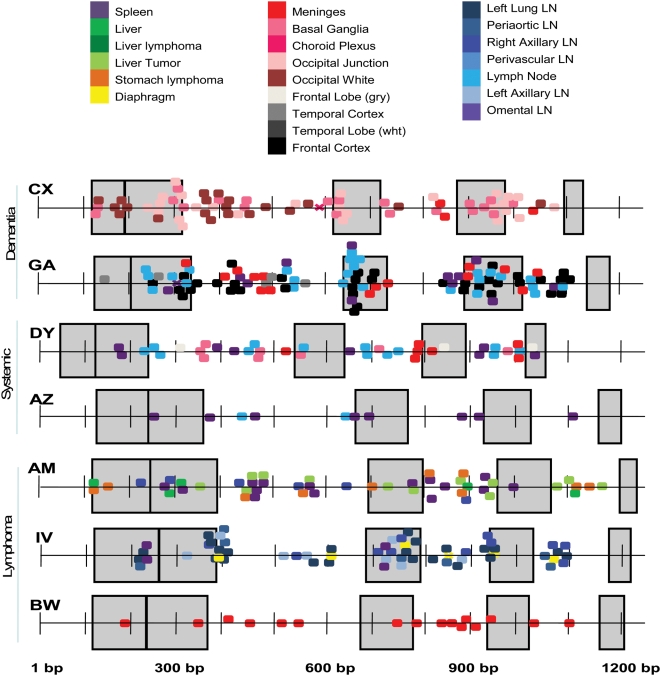
Summary of breakpoints in intra-tissue sequence populations.As noted along the bottom, the x-axis represents the 1200+ nucleotides incorporating the gp120 domain in HIV-1. The large transparent blue boxes represent the variable domains V1, V2, V3, V4 and V5 respectively. The variation in placement of the variable domains is due to natural genetic length variation between the patient's data sets and to deviation between sequencing reactions. Each plot displays the estimated location of break points found in every sequence for each patient (noted on the upper left of the plot). A colored box indicates the estimated location of a breakpoint identified in an individual sequence using bootscanning analysis. Each putative breakpoint is color-coded for a different tissue as shown in the figure.